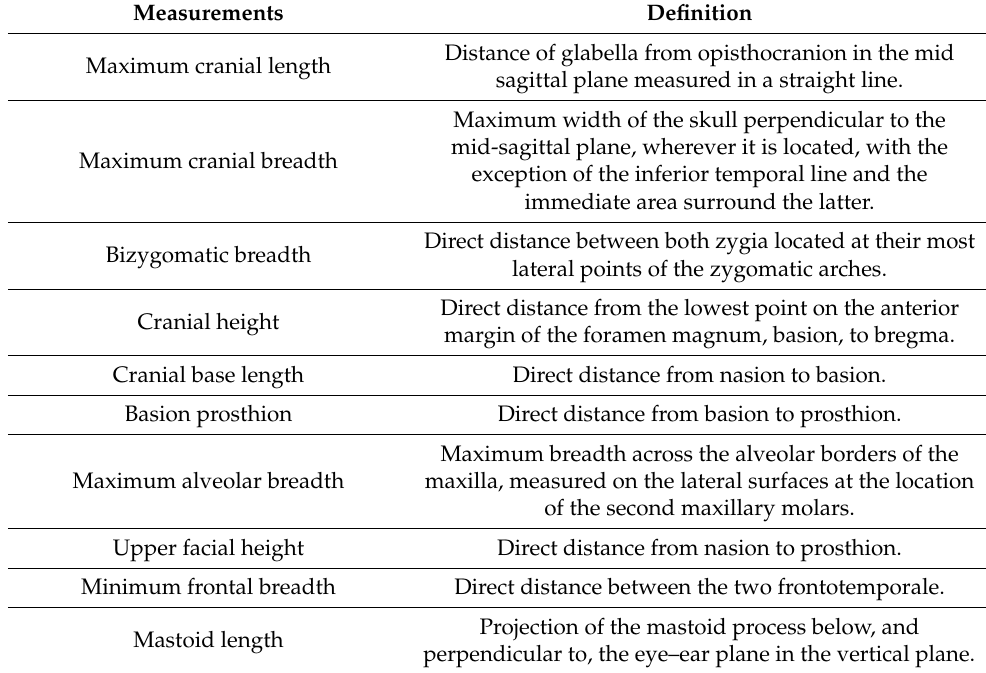
Table 1. Descriptions of cranial measurements